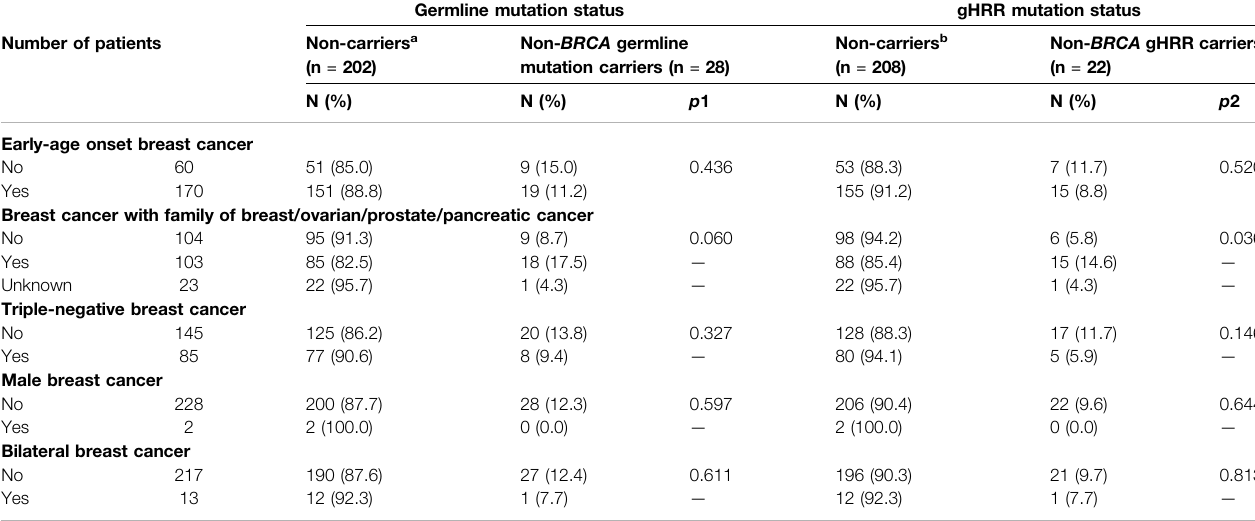
TABLE 4 | Germline non- BRCA mutation status in patients in different categories. Germline mutation status gHRR mutation status Number of